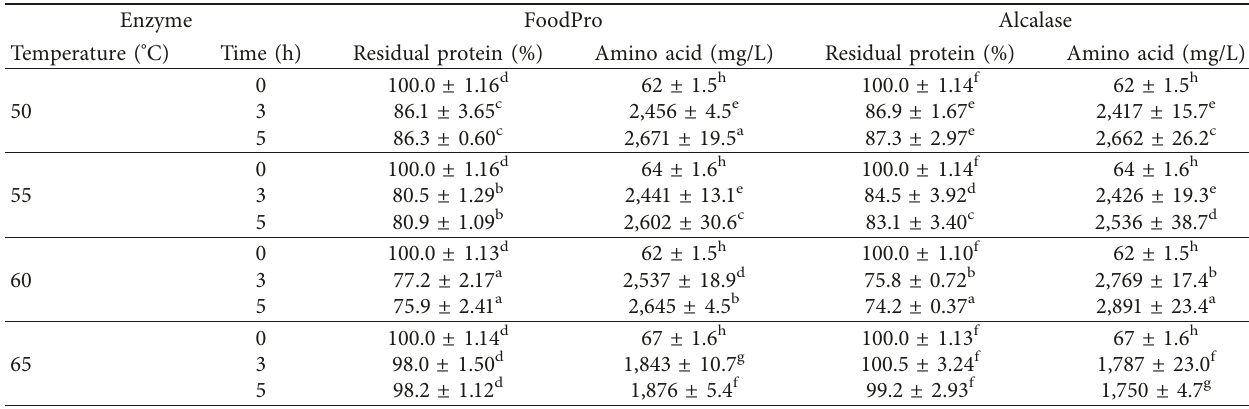
Table 2: Effects of temperature on the enzymatic hydrolysis of regenerated silk fibroin using FoodPro and Alcalase at pH 8.0. Enzyme FoodPro Alcalase Temperature ( ° C) Time (h) Residual protein (%) Amino acid (mg/L)